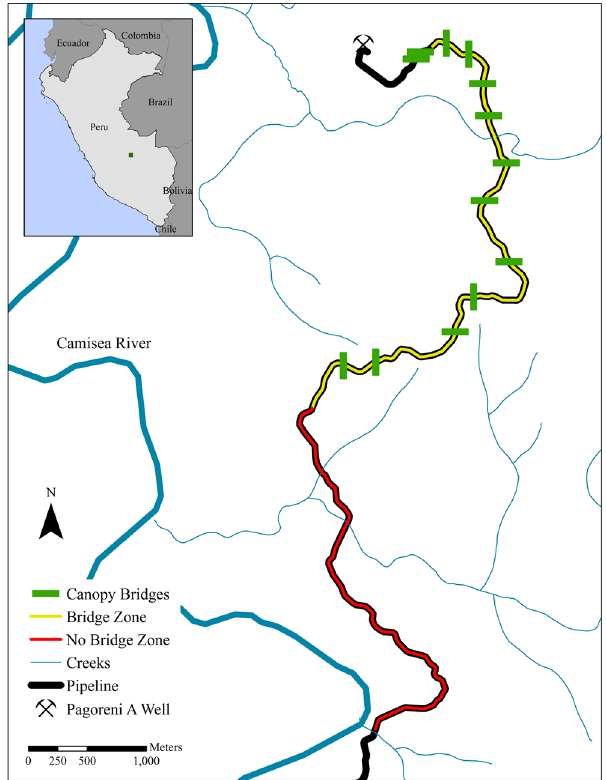
Figure 4. Map of the study area, including the location of natural canopy bridges (green bars), the Bridge Zone (yellow line, 5.2 km), and the No Bridge Zone (red line, 4.0 km) along the pipeline right-of-way (black outline). Map created by T.G. in ArcMap 10.3 (Environmental Systems Resource Institute, ArcMap 10.2 ESRI, Redlands California,